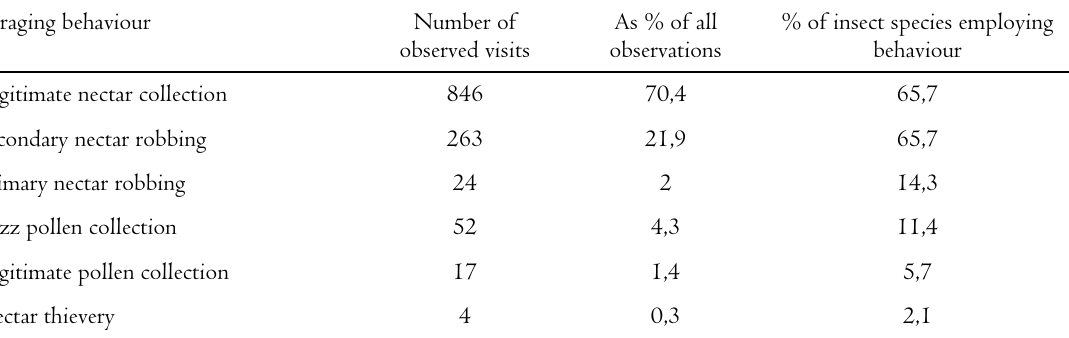
T ABLE 2. Foraging behaviours of insects visiting Arctostaphylos pungens flowers. Based on 1202 visits by 46 insect species observed during 565 foraging bouts. Behaviours are defined in the